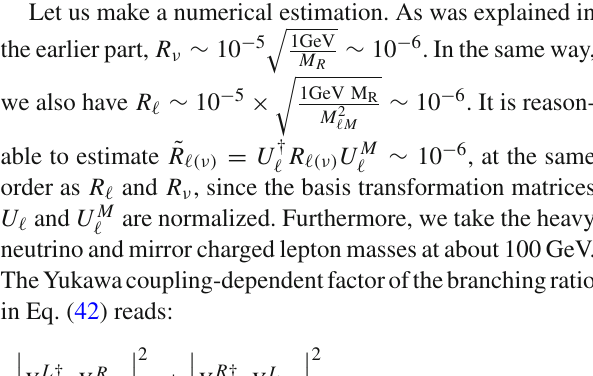
Fig. 4 Upper bounds on Yukawa couplings involving H 0 , H 0 , ˜ H 0 ( H 0 , ( i = 1 , 2 , 3 ) ), by the μ → e γ decay as a function of i 3 3 M (i) neutral Higgs scalar mass (upper panel) for m M (cid:4) = 80 ( 200 ) GeV, solid (dashed) lines; (ii) mirror charged lepton masses (lower panel) for m H 0 = 70 ( 300 ) GeV, solid (dashed) lines